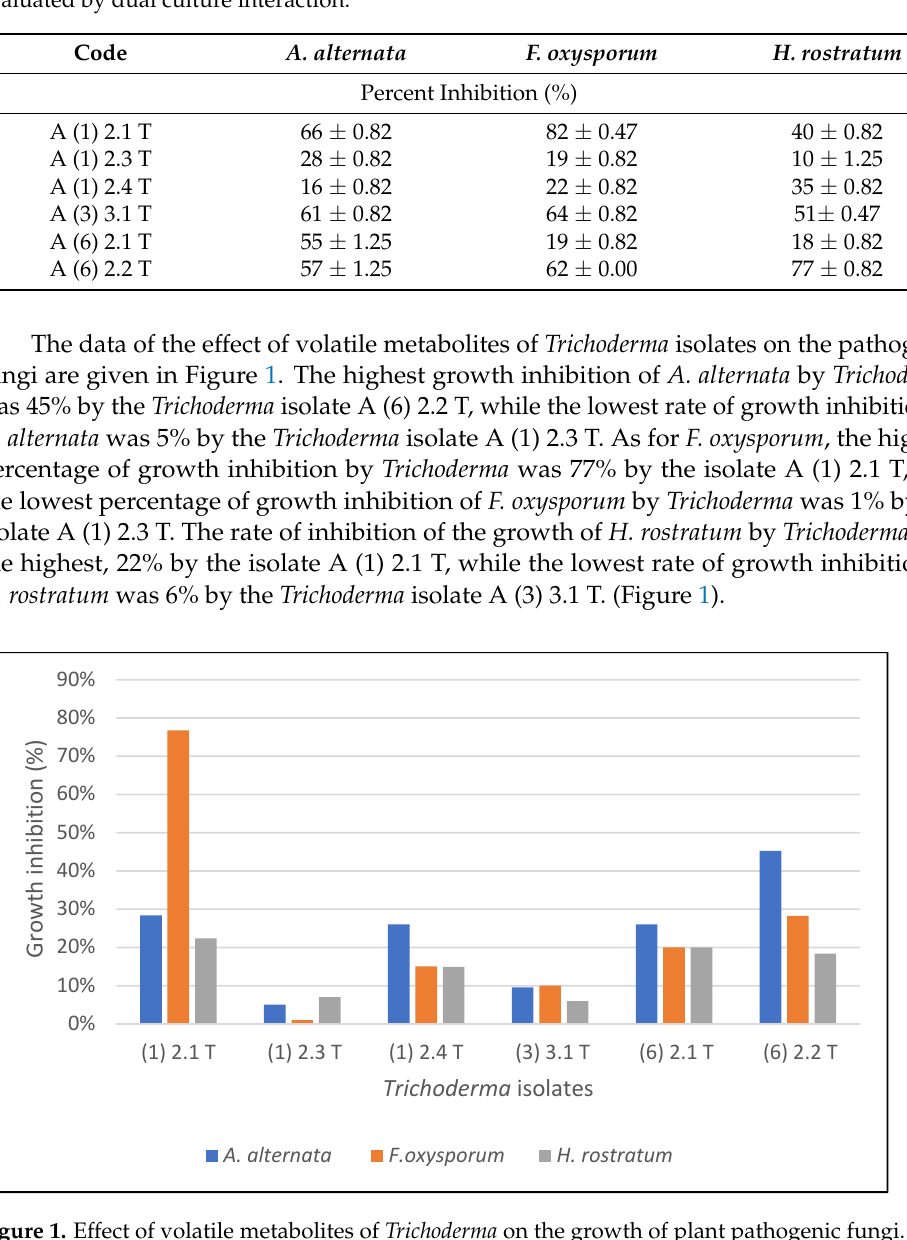
Figure 1. Effect of volatile metabolites of Trichoderma on the growth of plant pathogenic fungi.